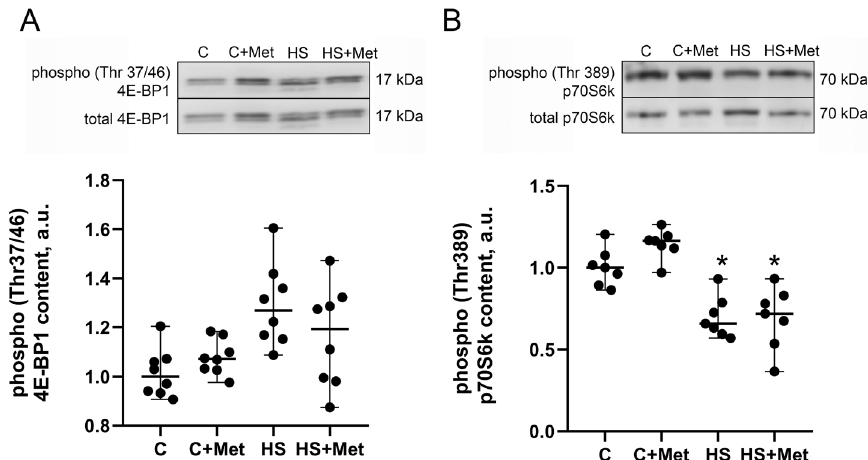
Figure 6. Effect of metformin pre-treatment on translation initiation factor 4E-binding protein 1 (4E-BP1) (Thr37/46) phosphorylation ( A ) and ribosomal protein S6 kinase beta-1 (p70S6K) (Thr389) phosphorylation ( B ) in rat soleus muscle. C, vivarium control, C+Met, vivarium control + metformin pre-treatment, HS, 7-day hindlimb suspension, HS+Met, metformin pre-treatment + 7-day hindlimb suspension. Scatter dot plots indicate median values, and the whiskers represent minimum and maximum values; n = 7–8/group. *: p < 0.05 vs. C.